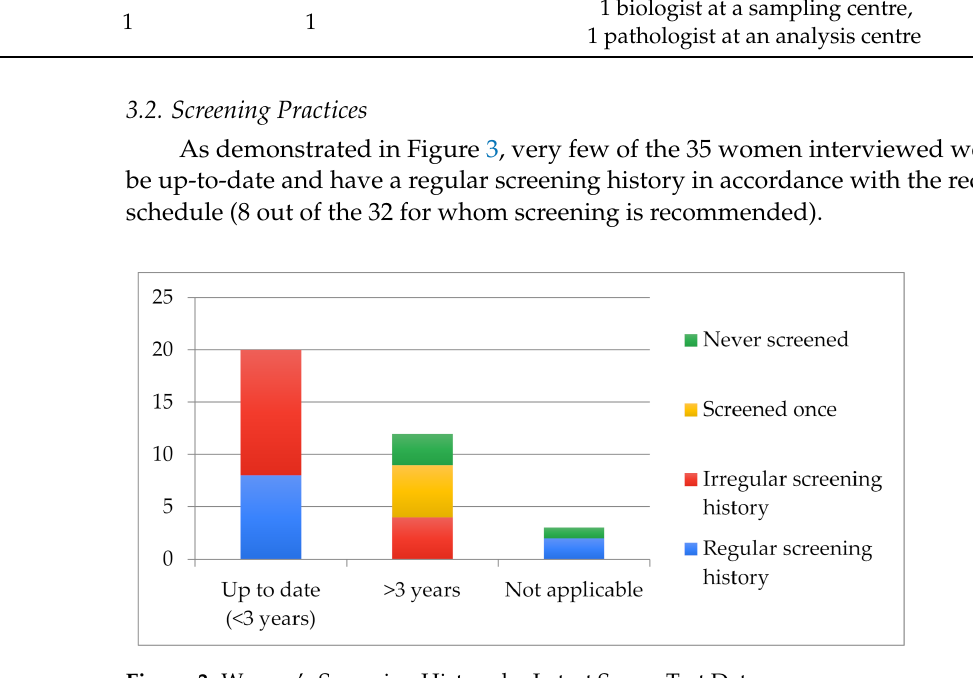
Figure 3. Women’s Screening History by Latest Smear Test